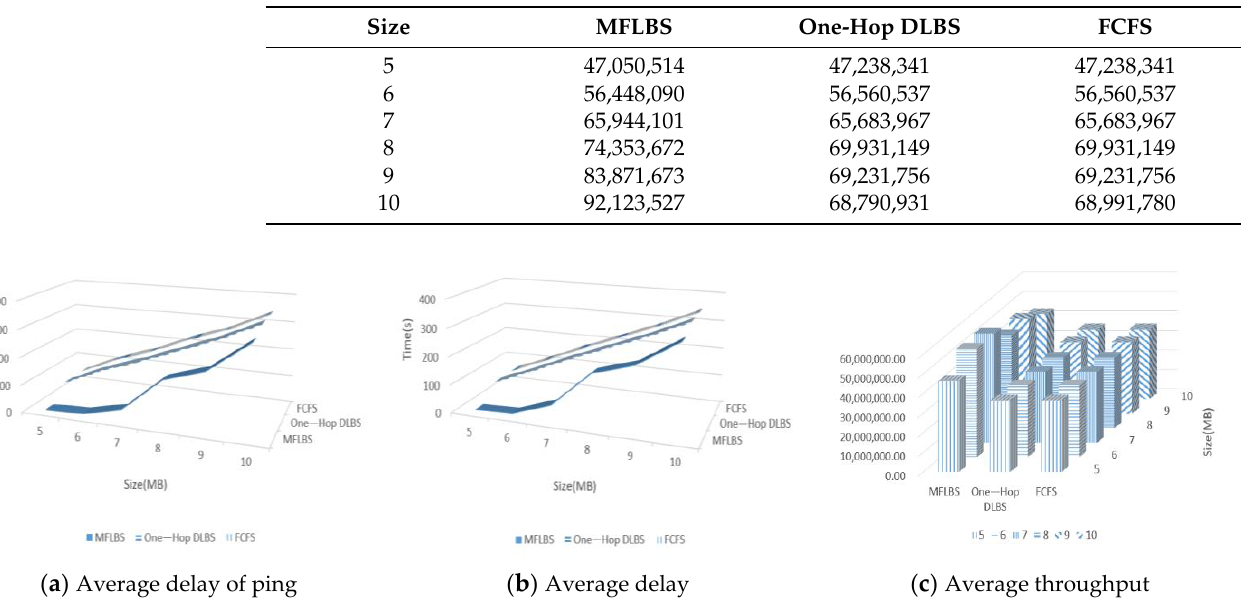
Figure 6. Three algorithms in FPN model under semi-central pattern. Table 6. Average throughput (MB) in FPN model under semi-central